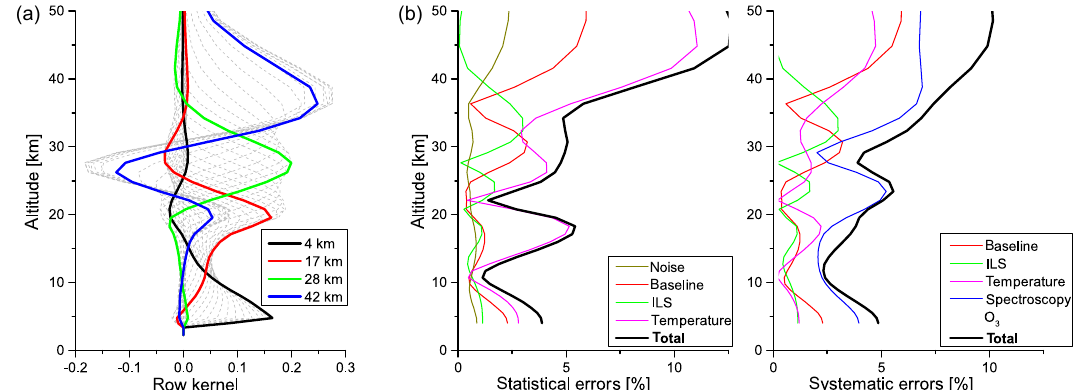
Figure 3. Characterization of the O 3 volume mixing ratio profiles obtained from the FTIR measurements at Altzomoni as shown in Fig. 2. (a) Row averaging kernels, all kernels are depicted as grey lines and kernels for a few different altitudes are highlighted by different colours. (b) Estimated statistic and systematic errors, where the errors resulting from the different uncertainty sources as listed in Table 1 are repre- sented in different colours. The total error is the root-sum-square of the individual errors and is shown as thick black